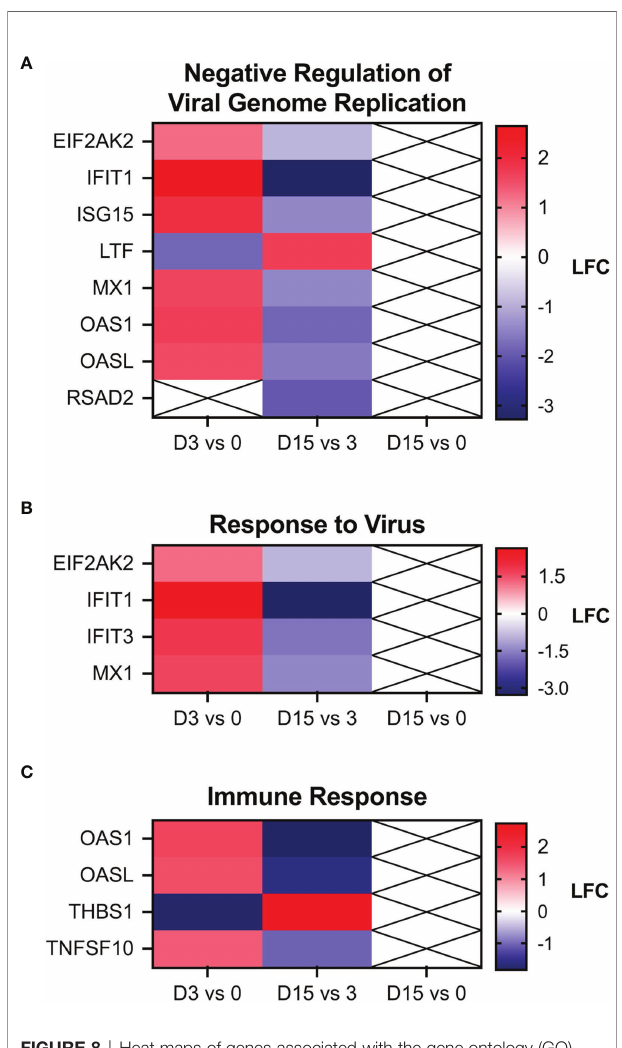
FIGURE 8 | Heat maps of genes associated with the gene ontology (GO) terms. (A) “ negative regulation of viral genome replication, ” (B) “ response to virus, ” and (C) “ immune response ” . The three GO terms shown here were the only ones found to be signi fi cantly enriched by the DAVID Functional Annotation tool. No GO terms were found to be enriched for the day 15 vs 0 comparison. Boxes with an X indicates an FDR >